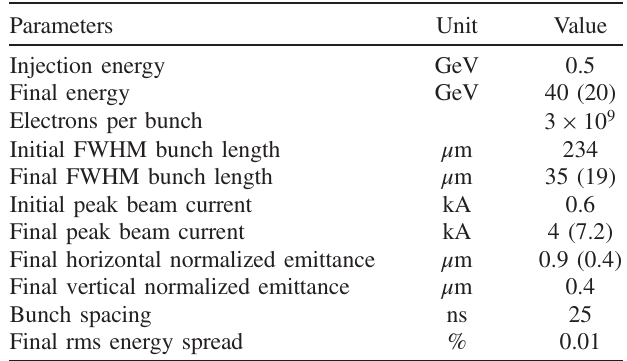
TABLE III. The main LHeC-ERL electron beam parameters. Peak current, bunch length, and transverse emittance were obtained from the tracking simulation. The numbers in paren- theses refer to the 20 GeV